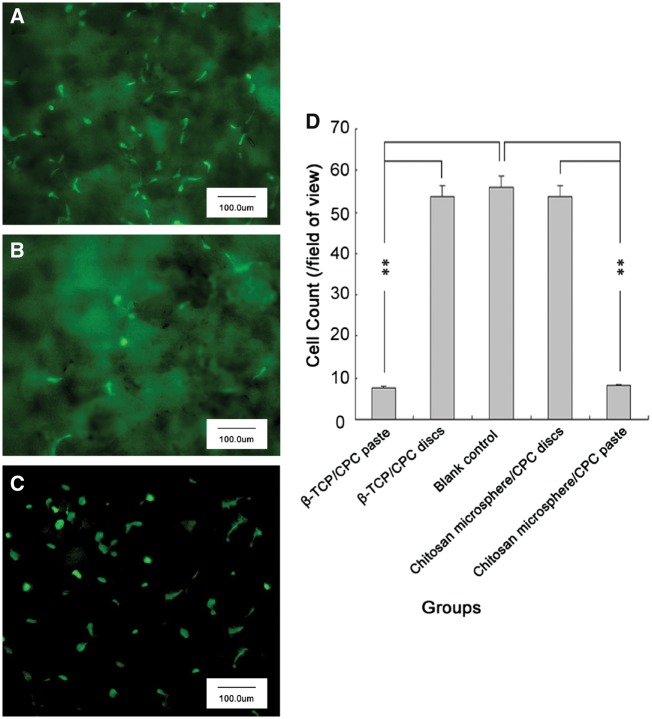
Fluorescence images of chitosan microsphere/CPC discs (A), chitosan microsphere/CPC paste (B), and the blank control (C), as well as cell counts the different groups (D) (**P < 0.01)